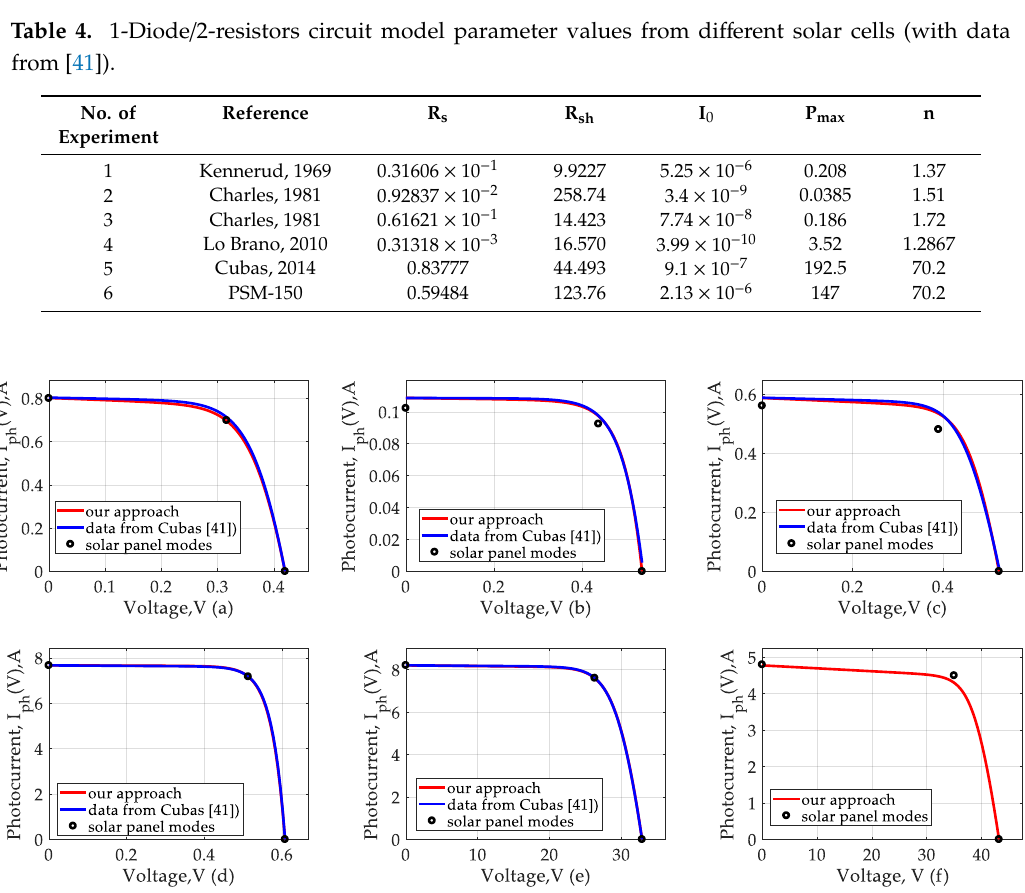
Figure 6. Volt-ampere curves in range 0 ≤ V ≤ V oc , ( a ) Experiment 1, ( b ) Experiment 2, ( c ) Experiment 3, ( d ) Experiment 4, ( e ) Experiment 5, ( f ) Experiment 6.